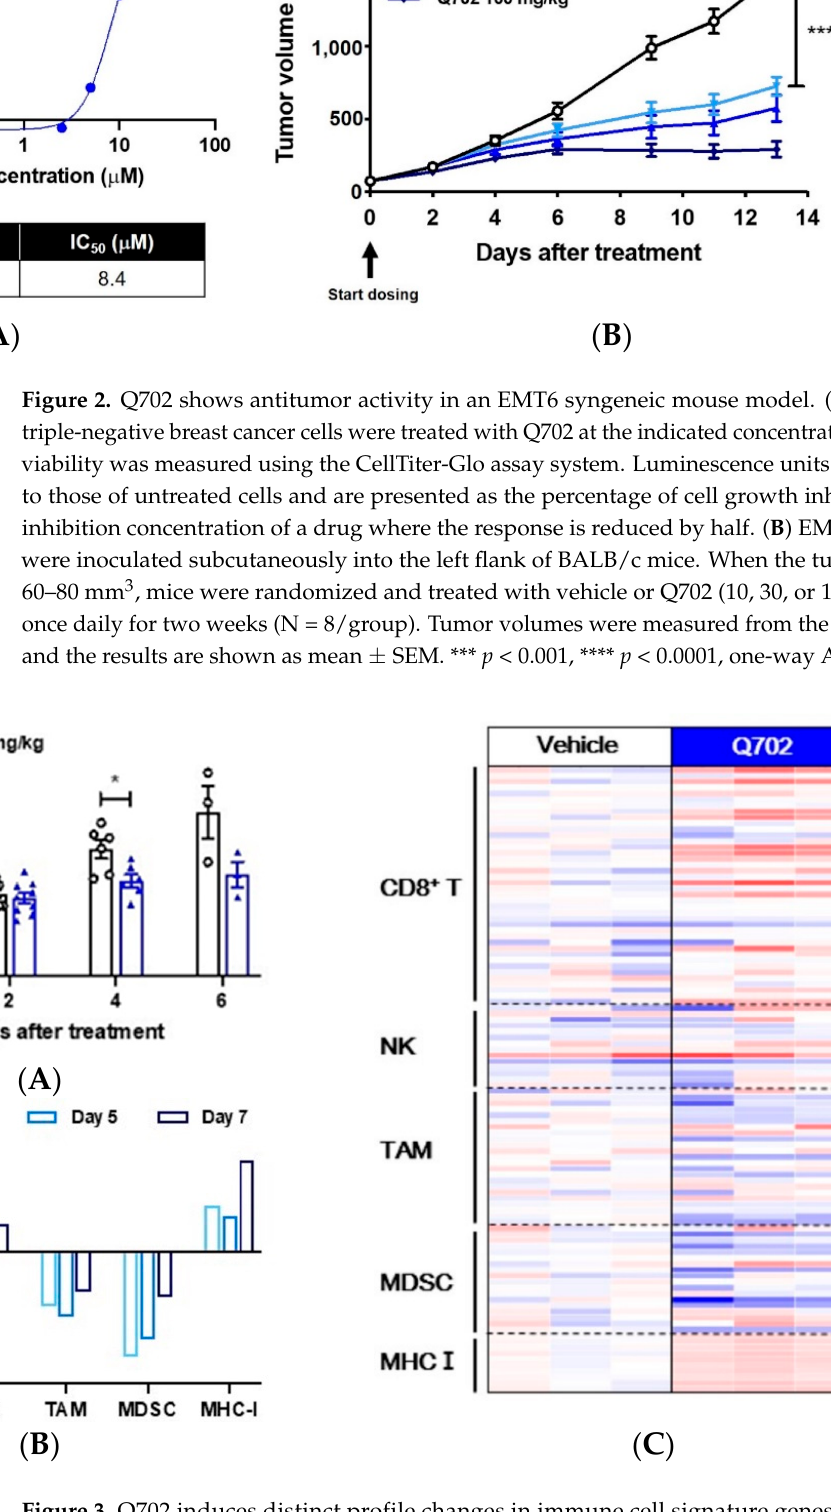
Figure 3. Q702 induces distinct profile changes in immune cell signature genes within the TME. EMT6 (1 × 10 6 ) cells were implanted into BALB/c mice. When the tumor size reached 60 − 80 mm 3 , mice were randomized and treated with vehicle or Q702 (30 mg/kg) orally once daily for the indi- cated days. ( A ) Tumor volumes were measured on days 2, 4, and 6 after the start of treatment, and the results are shown as mean ± SEM. * p < 0.05, unpaired student’s t -test. ( B ) On days 3, 5, and 7, the tumor samples were lysed and RNA-seq analysis was performed (N = 3 mice/group). Individual transcript counts from each tumor sample were normalized with an average count per million (CPM) of the respective transcripts from the vehicle group to demonstrate gene expression changes after Q702 treatment. The immune signature gene set and MHC-I gene set were analyzed to deter- mine the immune activation status in the tumor microenvironment. The graph shows the average log2-fold-change (log2FC) of the signature genes for each immune cell and the MHC-I gene set. ( C ) RNA-seq heatmap shows gene expression levels of general immune cell markers modulated by Q702 relative to the vehicle group. The heatmap was plotted with log2FC from the vehicle and Q702 groups for individual genes. The color scale denotes the normalized gene expression level. TAM, tumor-associated macrophages; NK, natural killer cells; MDSC, myeloid-derived suppressor cells. 3.3. Q702 Induces Drastic Changes in the Immune Cell Population in the TME To understand the effect of Q702 on the TME over time, immune cell subpopulations were compared after 5 or 22 days of treatment with either Q702 or the vehicle in an EMT6 syngeneic breast carcinoma model. The tumor volume on day 5 was similar between the vehicle and Q702 treatment groups; however, on day 22, there was a significant decrease in the tumor volume in the Q702-treated group (Figure 4a). Major histocompatibility com- plex class II (MHC-II) and CD206 were used to distinguish classically (M1) and alterna- tively (M2) activated macrophages after total macrophages were gated with F4/80 and CD11b (Supplementary Figure S2). Q702 treatment for 5 days reduced the percentage of tumor-infiltrating CD11b + Ly6G − Ly6C + monocytes (monocytic MDSCs, M-MDSCs) by 2.3- fold from 12% to 5.3%. In contrast, the percentage of CD11b + F4/80 + MHC-II + CD206 − mac- rophages (M1 macrophages) increased more than 5-fold, from 4% to 23%. In addition, the percentage of CD11b + F4/80 + MHC-II − CD206 + macrophages (M2 macrophages) decreased by 2.7-fold, from 34% to 13%, resulting in a decrease in the percentage of M2 macrophages persisting through day 22. As a result, the proportion of total macrophages (CD11b + F4/80 + ) in the TME was significantly reduced (Figure 4b). In addition to modulating the innate immune response, Q702 can also regulate the activity of adaptive immune cells, such as T cells. On days 5 and 22, CD45 + CD3 + CD4 − CD8 + (CD8 T cell) populations were significantly increased in the Q702-treated group compared